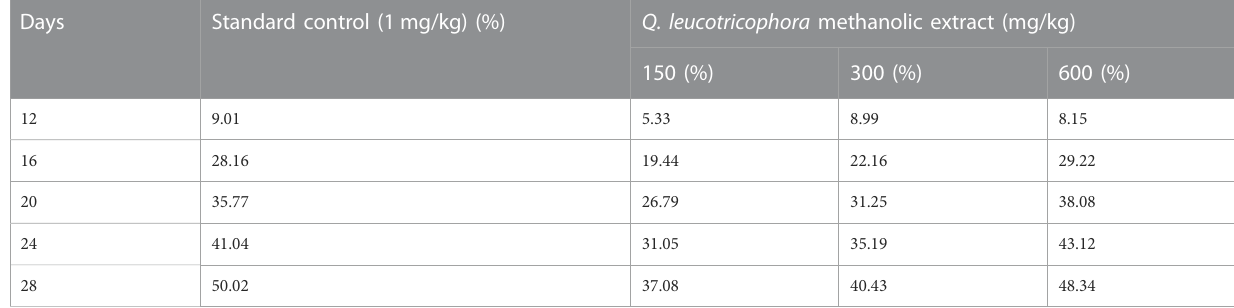
TABLE 3 Effect of Quercus leucotrichophora extract on % reduction of paw edema in CFA-induced arthritic